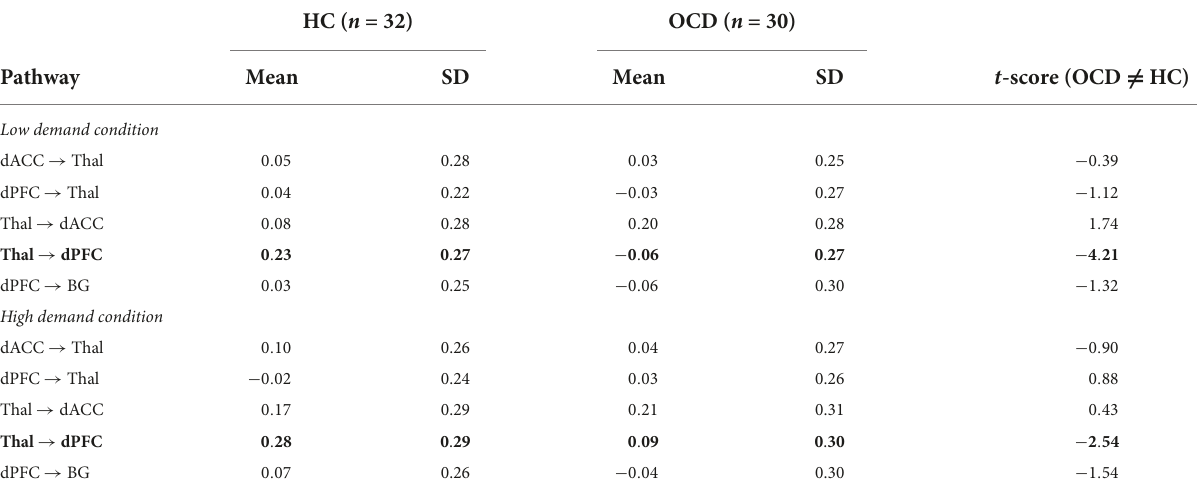
TABLE 3 Parameters for contextual modulation and statistical analyses (significant effects in